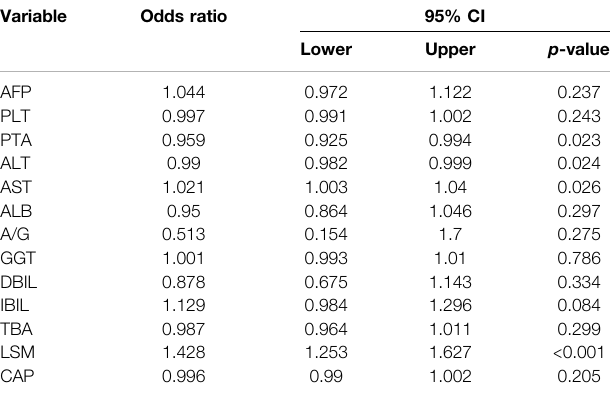
TABLE 2 | Logistic regression of signi fi cant fi brosis in the development cohort.